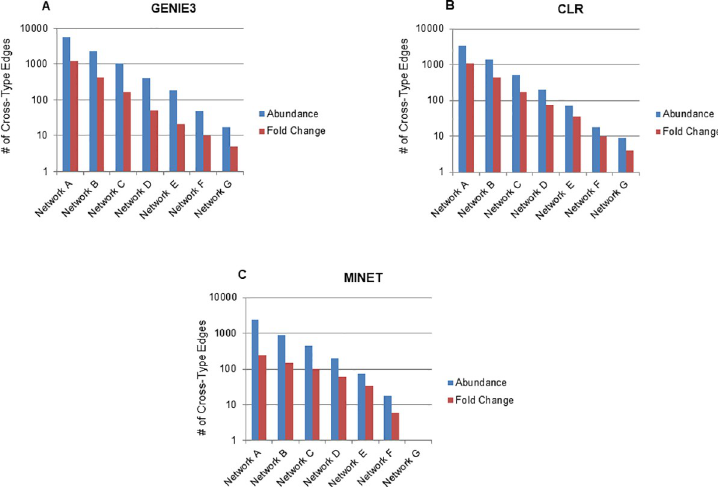
Fig 7. Effects of using fold change values on cross-type edges. (A) Using a smaller dataset of abundance values for proteins and transcripts, networks were inferred using GENIE3 and cross-type edges determined for each network (blue bars). Similar networks were also inferred for fold change values using this same dataset (red bars). (B) The same analysis using CLR instead of GENIE3. (C) The same analysis using MINET instead of